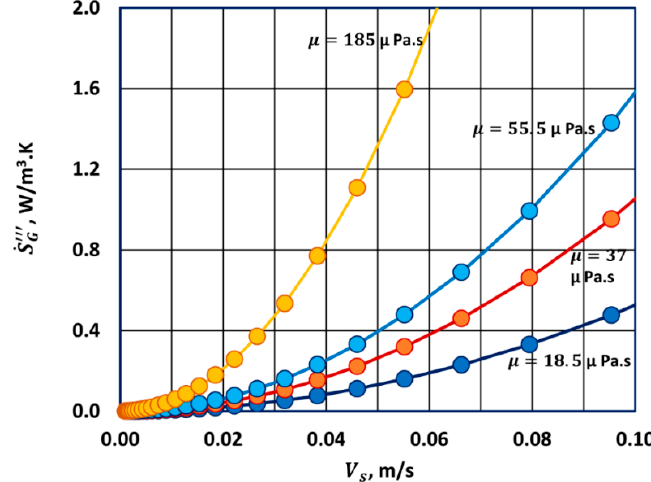
Figure 11. E ff ect of fluid viscosity on the rate of entropy generation per unit volume of the packed bed in laminar flow ( T = 298.15 K, d p = 1 mm, ε = 0.40, ρ = 1.184 kg / m 3 ). The data points are generated using Equation (50).